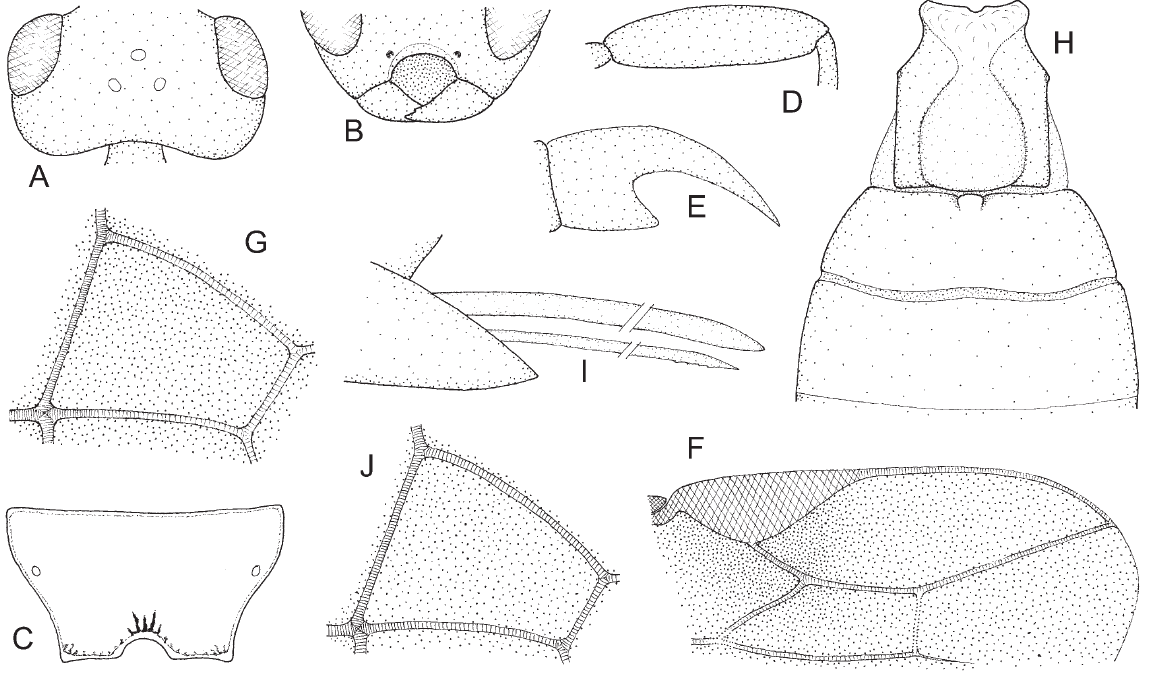
Fig. 3. Bracon ( Glabrobracon ) dichromus Wesmael, 1838 (A-I: ♀ holotype). A . Head in dorsal view. B . Head in frontal view. C . Propodeum. D . Hind femur. E . Claw. F . Distal part of right forewing. G . First discal cell of right forewing. H . Tergites 1-3. I . Hypopygium and ovipositor apparatus. J . First discal cell of right forewing